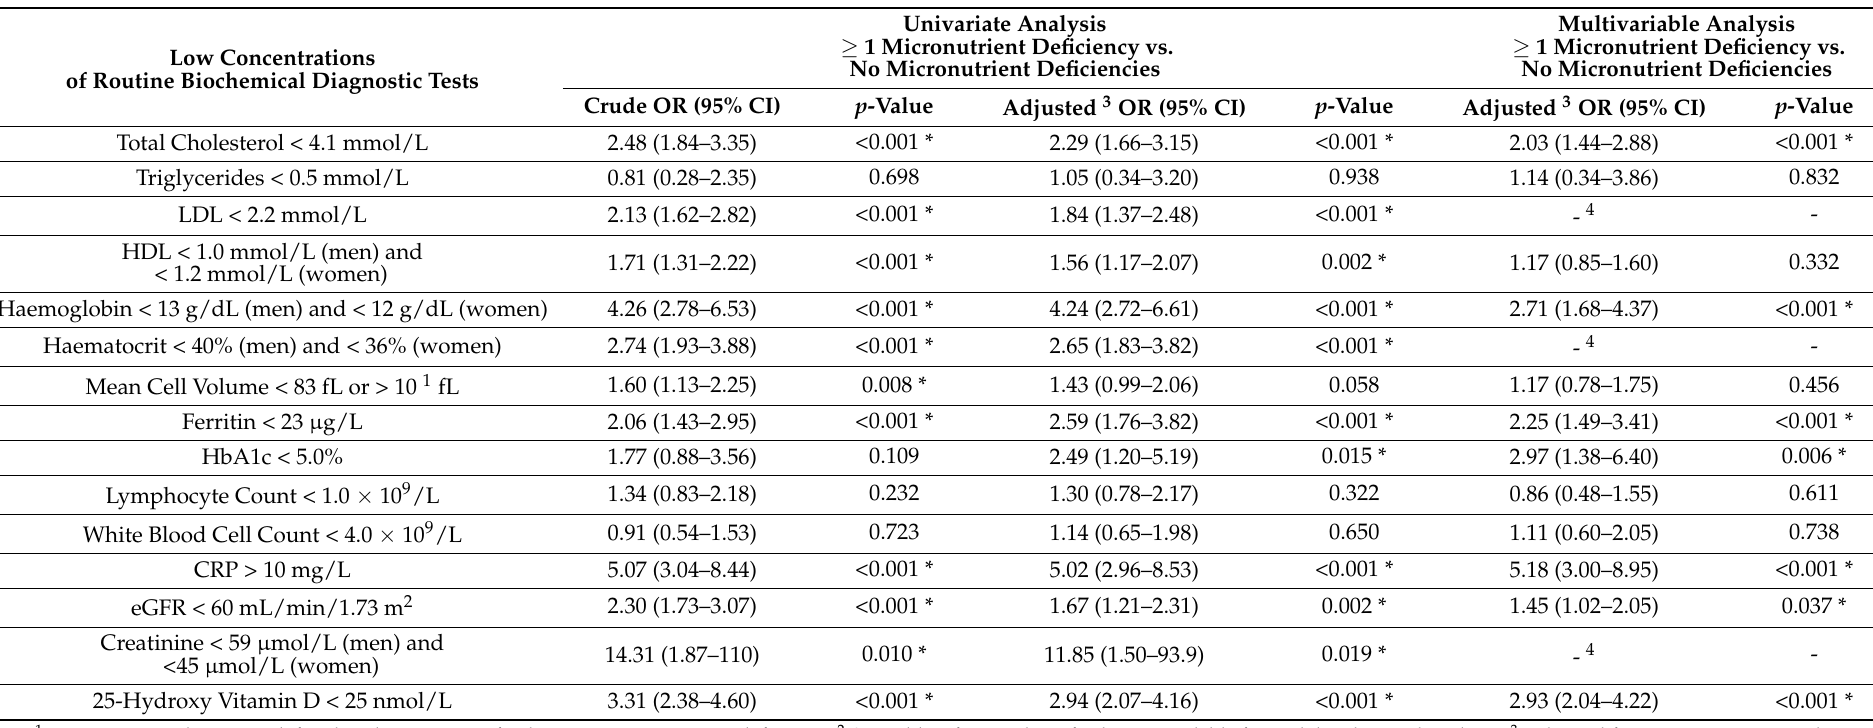
Table 4. Multiple univariate and multivariable logistic regression analyses of poor nutritional status 1 as dependent binary variable and each routine biochemical diagnostic test individually as independent binary variable, in unadjusted and adjusted models 2 (Stages 1a and